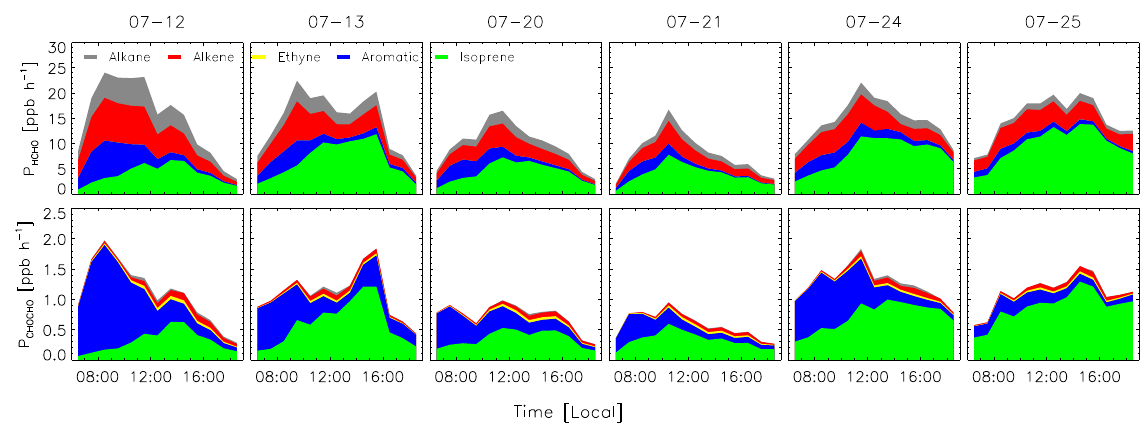
Figure 3. Production of HCHO and CHOCHO from different NMHCs precursors in the model base case (M0) for the 6 cloud-free days